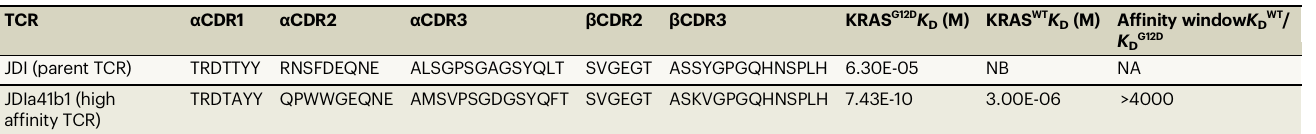
Table 4 | CDR sequences and binding af fi nities of TCRs used in structural analysis